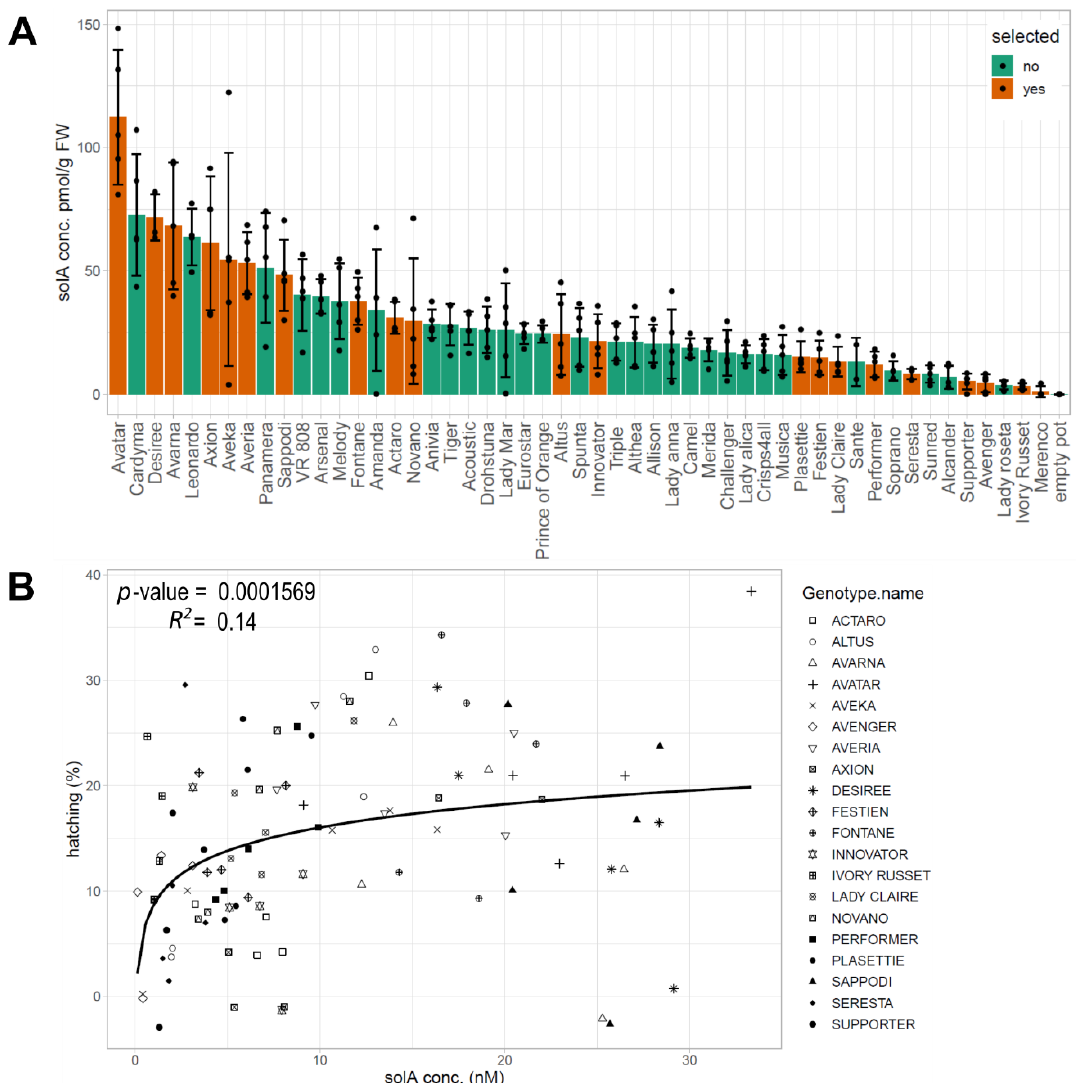
Figure 1. ( A ): solA concentrations in pmol/g FW of 51 commercial potato cultivars measured by UHPLC-MS/MS (solA_MRM). Colors indicate whether the species was selected for further experiments: red yes, green no. ( B ): solA concentrations of selected cultivars from A plotted against average hatching percentage. A logarithmic relationship was detected with R 2 value of 0.14 and a significant p